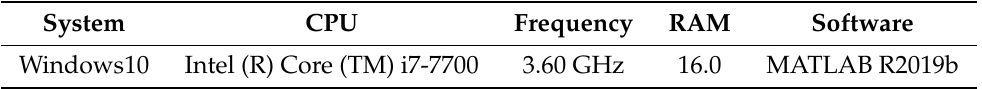
Table 1. The experimental environment information.